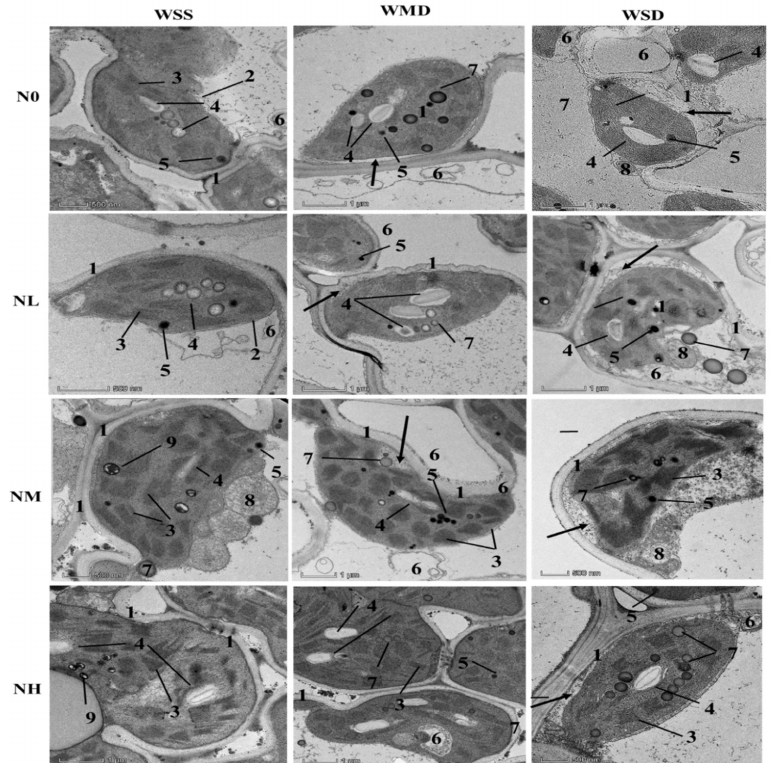
Figure 4. Transmission electron microscopy (TEM) images of the leaf mesophyll rates of rice under different SRN S fertilizer rates and different water regimes: (1) cell walls; (2) chloroplasts; (3) thylakoid; (4) starch grains; (5) plastoglobuli; (6) vacuoles; (7) lipid drop; (8) mitochondria; (9) loop of